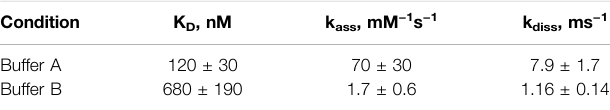
TABLE 2 | Af fi nity of the BHQ-2 amine to the G-quadruplex aptamer estimated from the data on biolayer interferometry.